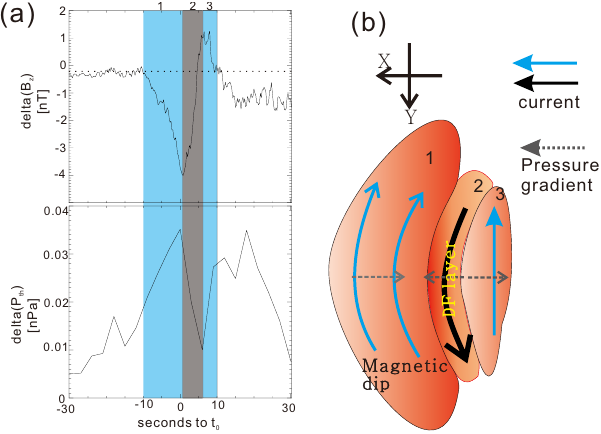
Figure 4. Illustration of the current system associated with the mag- netic dip ahead of DF. (a) The difference of magnetic field B z and plasma pressure between big dip events and small dip events. The variations were obtained by subtracting the average value between t 0 –4min to t 0 –3min from the statistical median. (b) A cartoon to show the current system of magnetic B z dip, derived from the dif- ferent variations of magnetic field B z and plasma pressure between big dip events and small dip